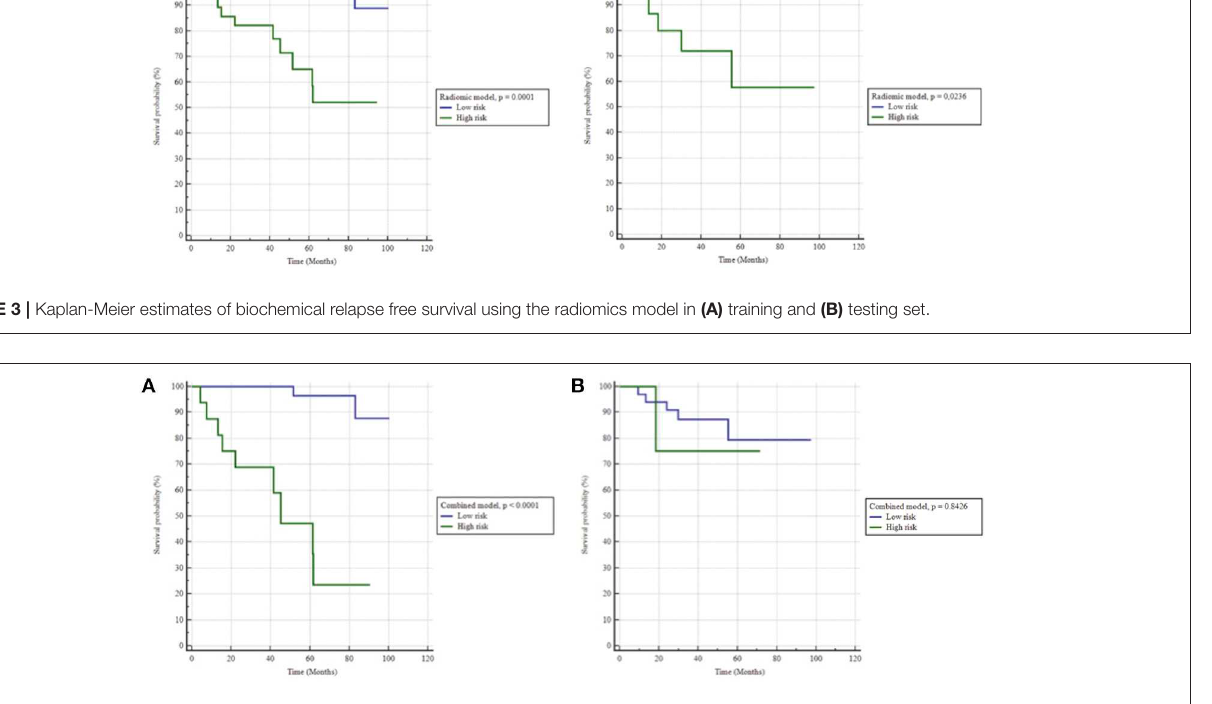
FIGURE 4 | Kaplan-Meier estimates of biochemical relapse free survival using the radiomics + clinical model in (A) training and (B) testing set.